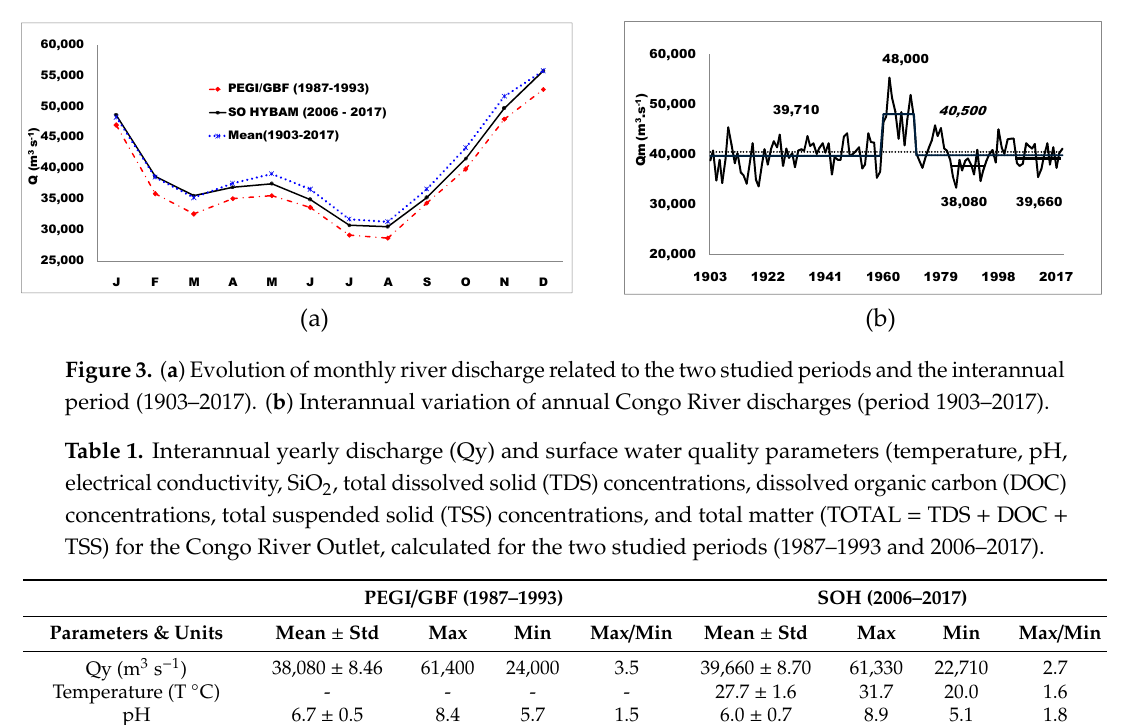
Table 1. Interannual yearly discharge (Qy) and surface water quality parameters (temperature, pH, electrical conductivity, SiO 2 , total dissolved solid (TDS) concentrations, dissolved organic carbon (DOC) concentrations, total suspended solid (TSS) concentrations, and total matter (TOTAL = TDS + DOC + TSS) for the Congo River Outlet, calculated for the two studied periods (1987–1993 and 2006–2017).